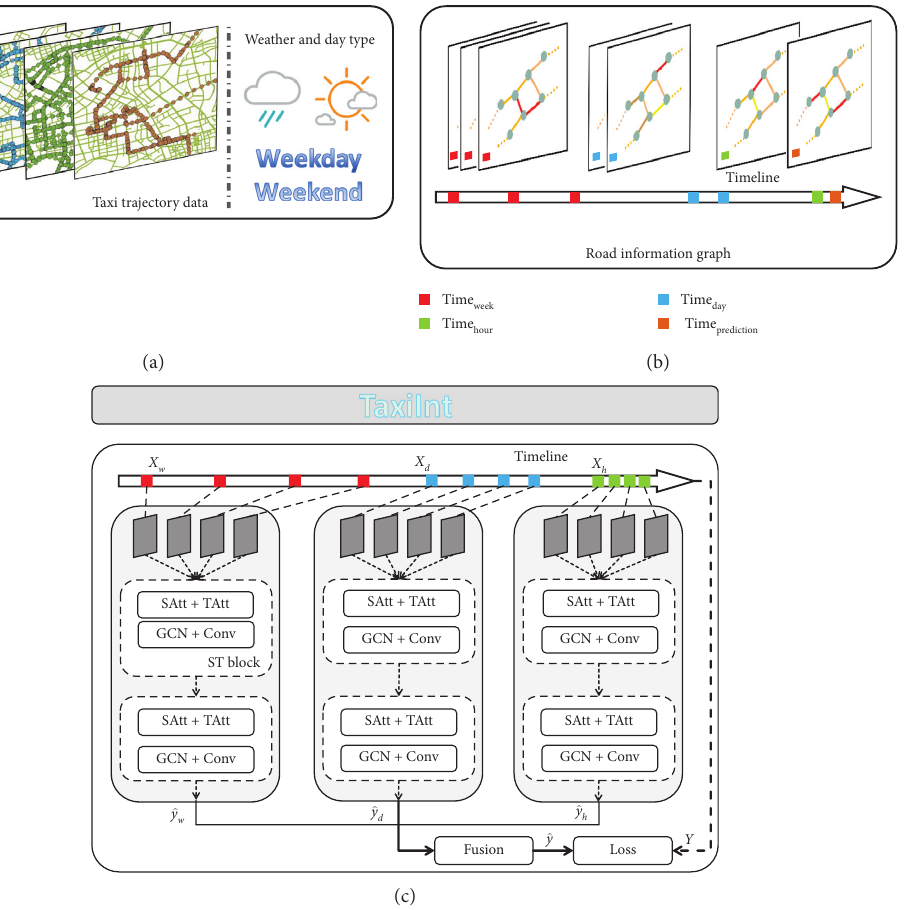
Figure 1: Illustration of the overall architecture of the proposed